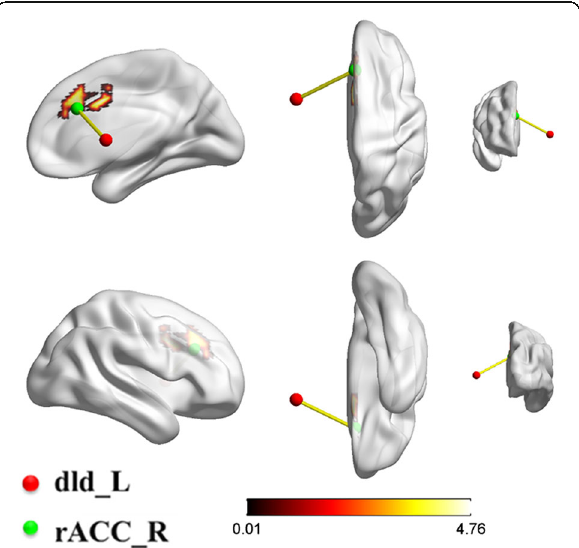
Fig. 3 Merging of ROI-whole brain and ROI-ROI analyses. The warm color in the statistical differences map exhibited the increased FCs between the dId_L and the whole brain in males (ROI-whole brain analysis). The red ball represented the dId_L, the green ball represented the rACC_R, and the yellow rod represented the statistically increased FC between the dId_L and the rACC_R in males ( ROI-ROI analysis ) . L, left; R, right; dId, dorsal dysgranular insula; rACC, rostral anterior cingulate cortex; ROI, region of interest; FCs, functional